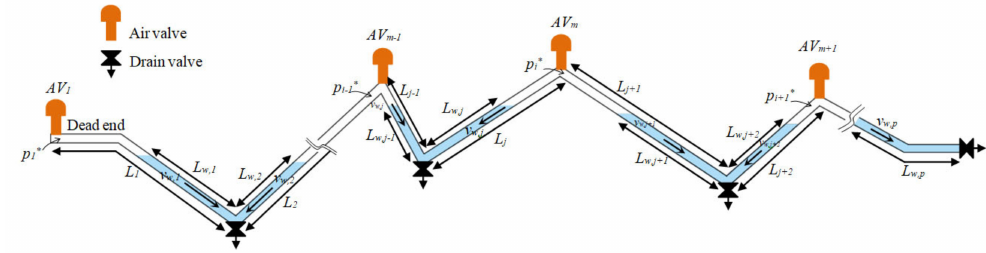
Figure 1. Diagram of draining maneuver in a water installation with several air pockets and several air